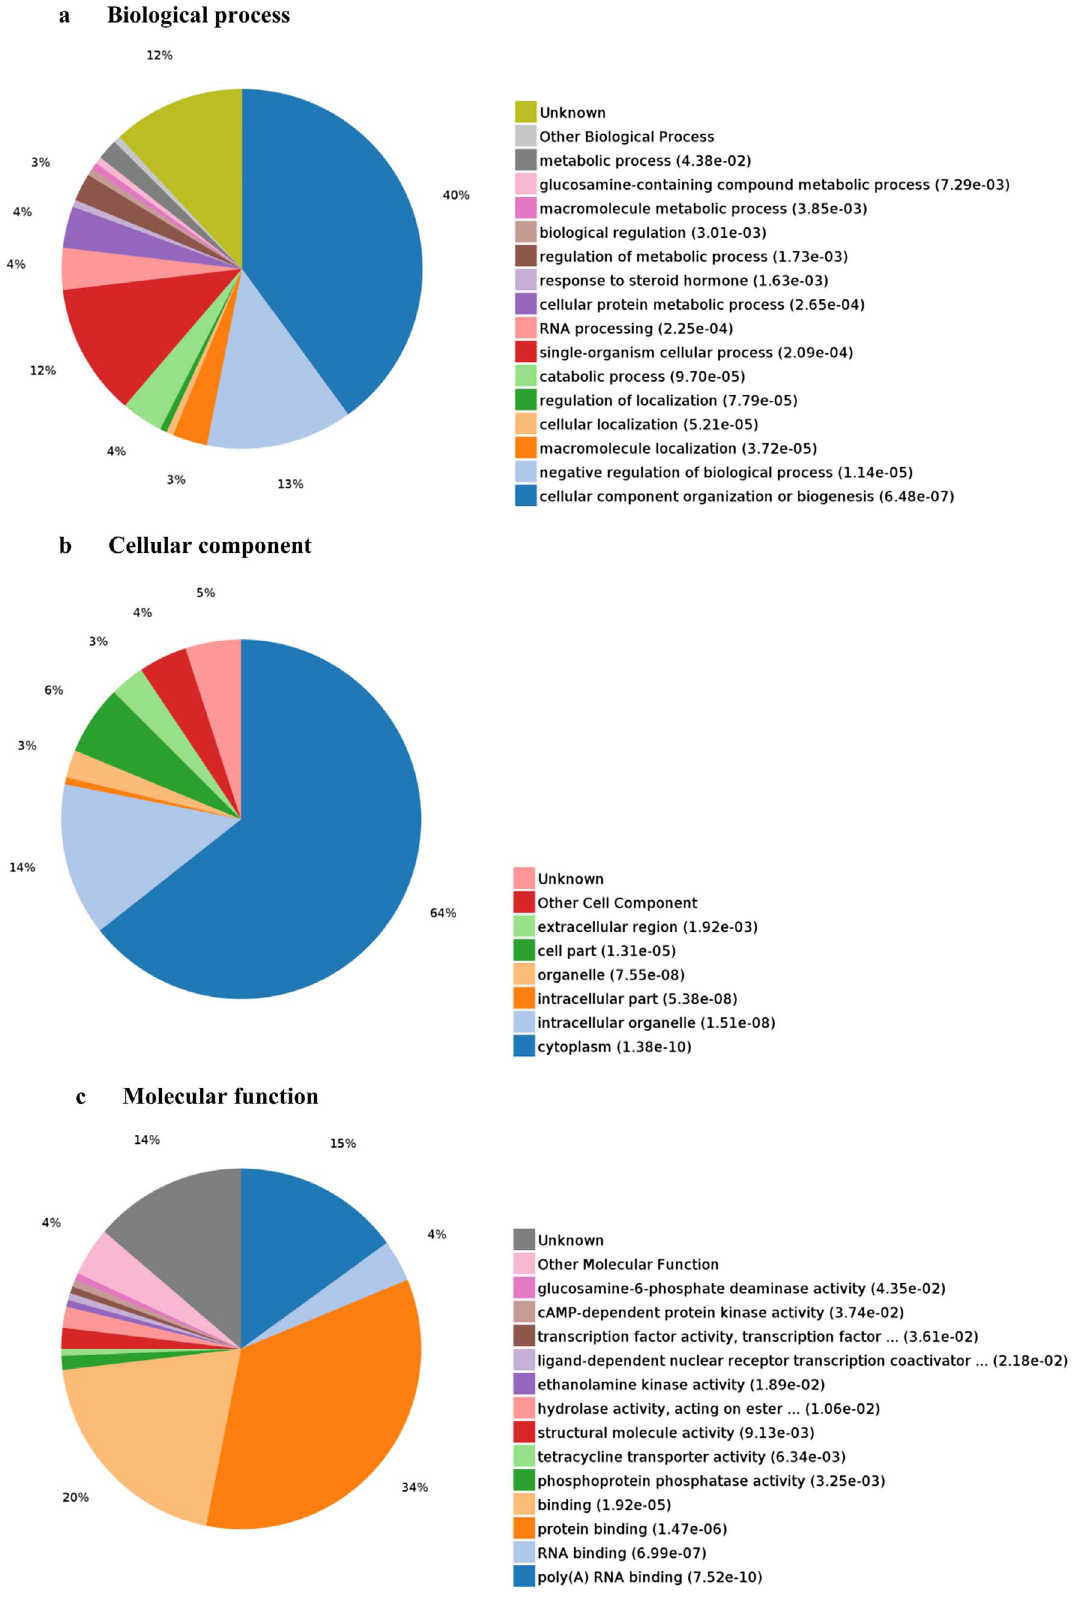
Figure 5. Gene ontology analysis of 163 proteins differentially expressed in DF-1 cells transiently transfected with EtAMA1. Proteins were annotated based on biological process, cellular component, and molecular